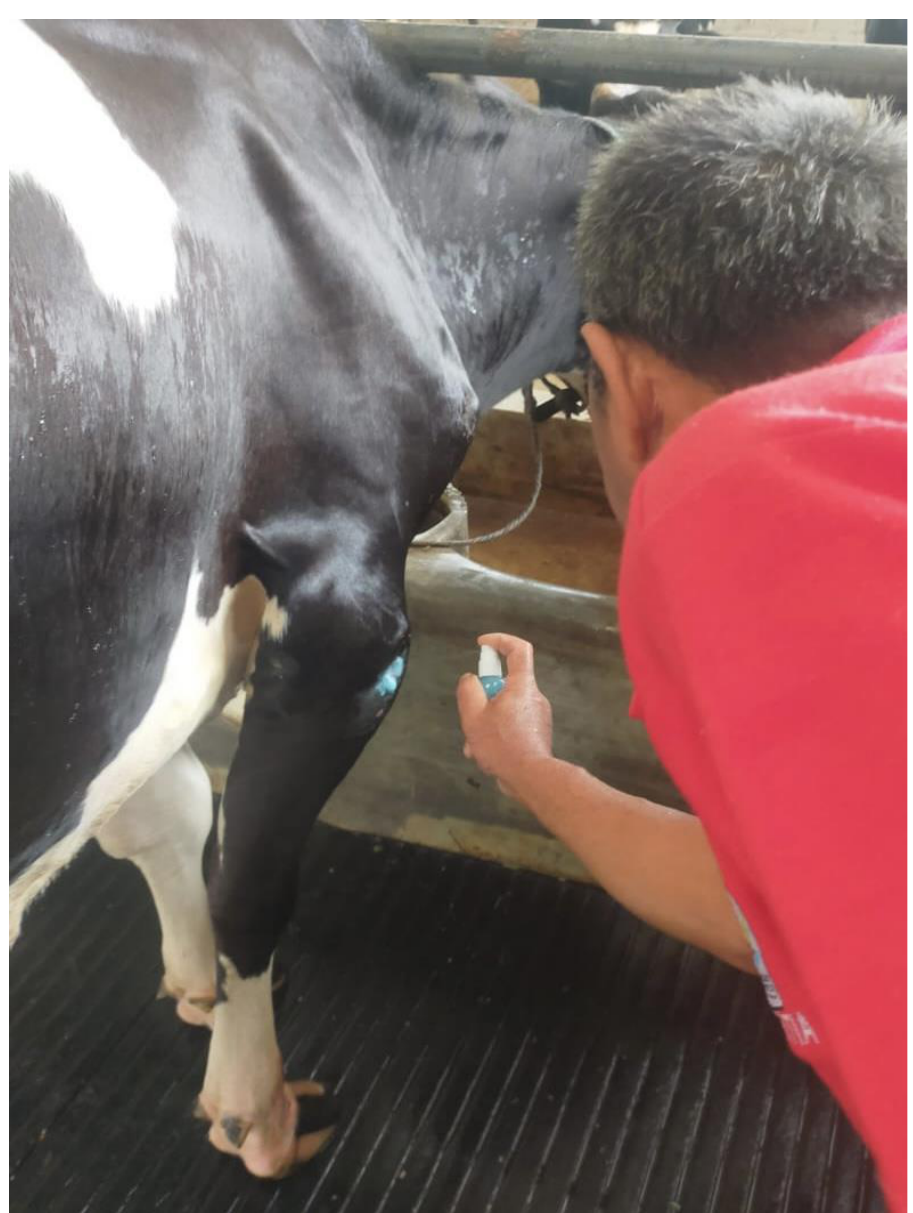
Figure 2. An FMD-afflicted dairy cow in Indonesia in recovery, with a chronic decubitus ulcer receiving topical spray treatment of lesions with the topical anaesthetic wound formulation (TAF) resulting in improved wound healing.